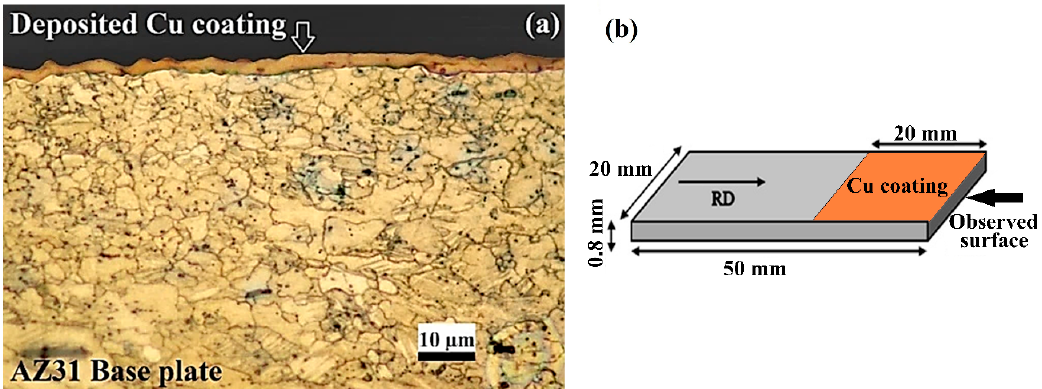
Figure 8. Light microscopy observation of AZ31 base metal with Cu coating, before USW ( a ) Figure 8. microstructure with Cu coating; ( b ) schematic of observed surface; (RD: Rolling direction).